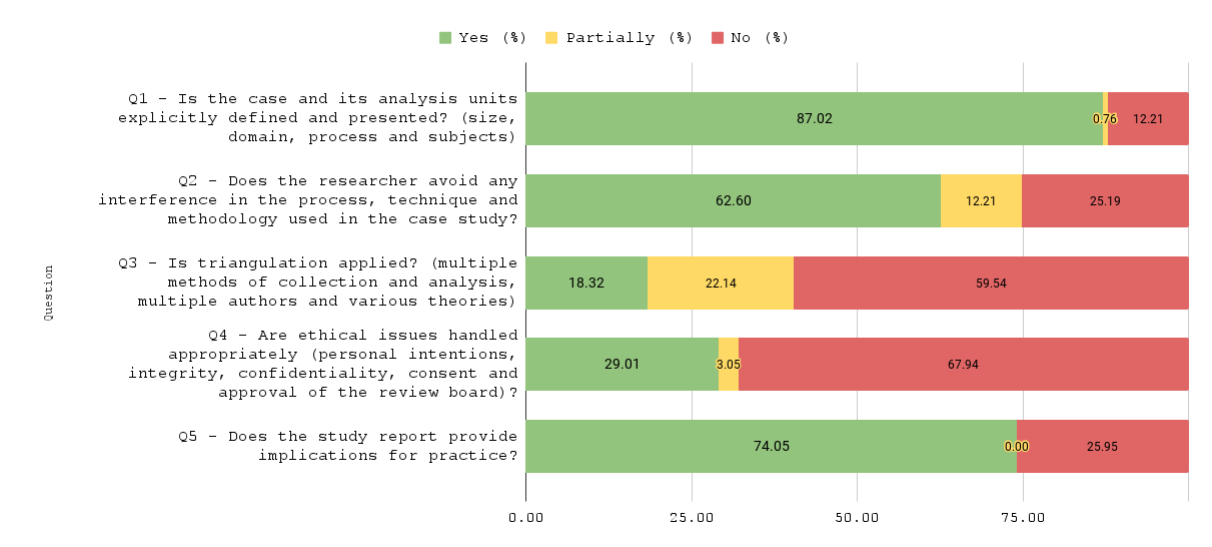
Figure 5. Answers to specific case study